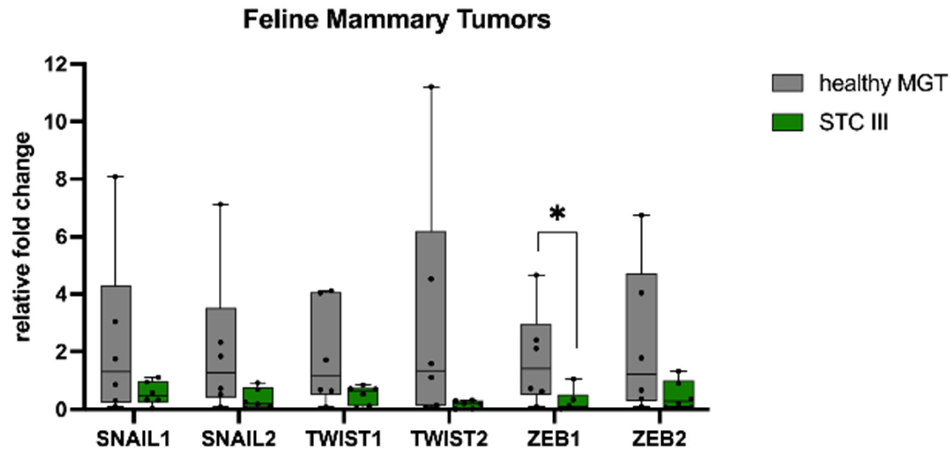
Figure 3. mRNA expression of SNAIL1, SNAIL2, TWIST1, TWIST2, ZEB1 , and ZEB2 in feline mammary tumors. SNAIL1, SNAIL2, TWIST1, TWIST2, ZEB1 , and ZEB2 mRNA expression was lower in simple tubular carcinomas (STC) grade III than in healthy tissues. MGT, mammary gland tissue. * p < 0.05.